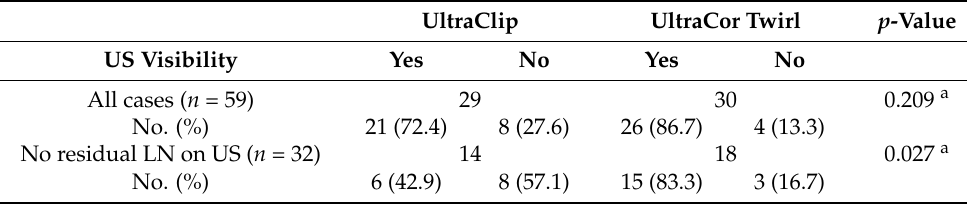
Figure 2. A 51-year-old woman with left breast cancer and ipsilateral axillary metastatic lymph node (LN) underwent UltraClip insertion before neoadjuvant chemotherapy (NAC). ( A , B ): The clip (arrow) was deployed at the cortex of the histologically proven metastatic LN by ultrasound (US) ( A ), and the location was confirmed by mammography ( B ). ( C – E ): After NAC, the size of the LN decreased, but remained suspicious on US. The clip (arrow) was also easily identifiable in the residual metastatic LN on US ( C ): US-guided wire localization was performed, and the location was confirmed by mammography ( D ). The wire was successfully located at the clipped LN, and subsequent specimen mammography confirmed that it was successfully retrieved ( E ). Table 2. Comparison of US visibility between the two tissue